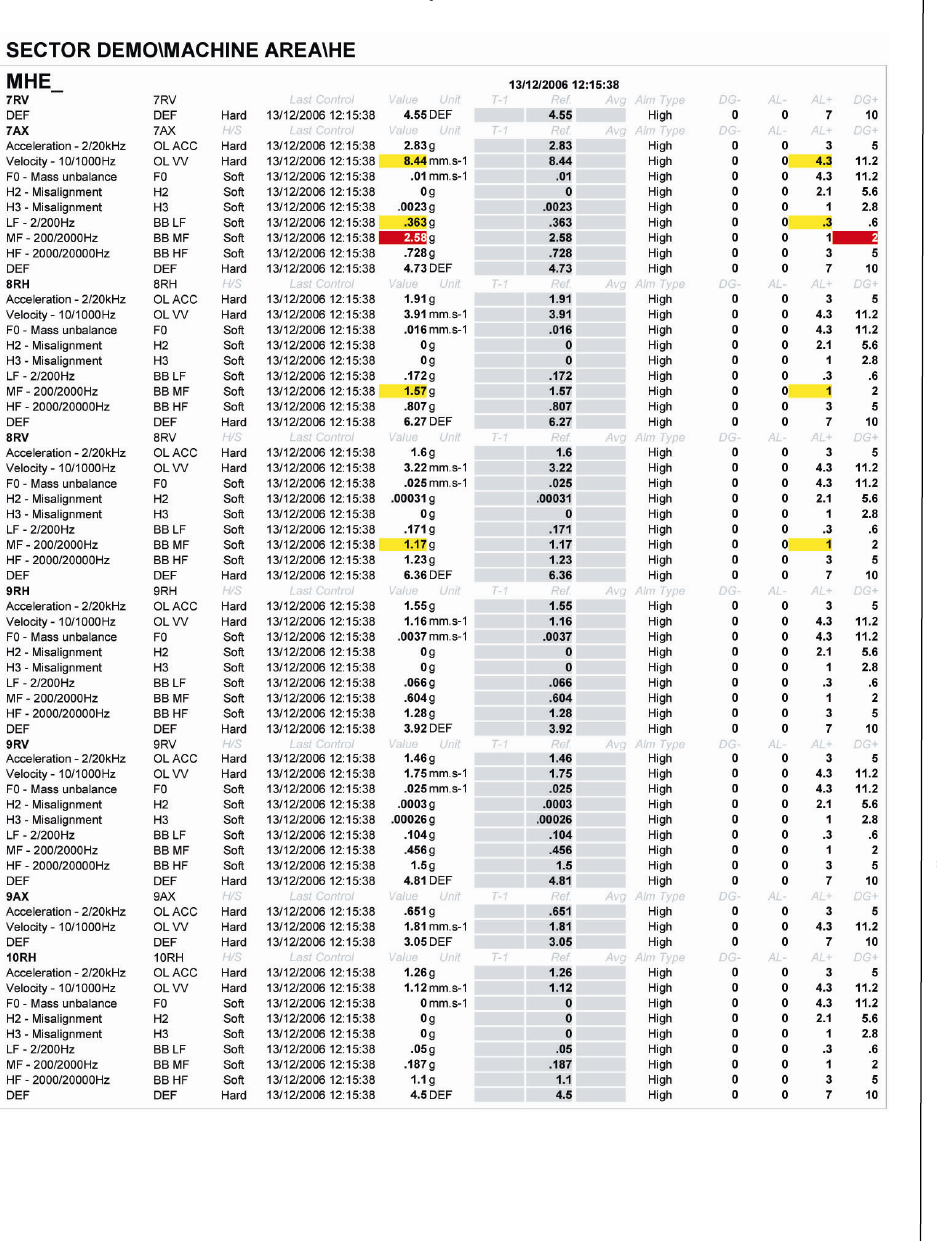
Table 5 – The measured values of vibration levels, measuring point 7, vertical direction –RV Таблица 5 – Измеренные значения уровня шума , контрольная точка 7, направление RV- по вертикали Tabela 5 – Izmerene vrednosti nivoa vibracija, merno mesto 7, smer RV –